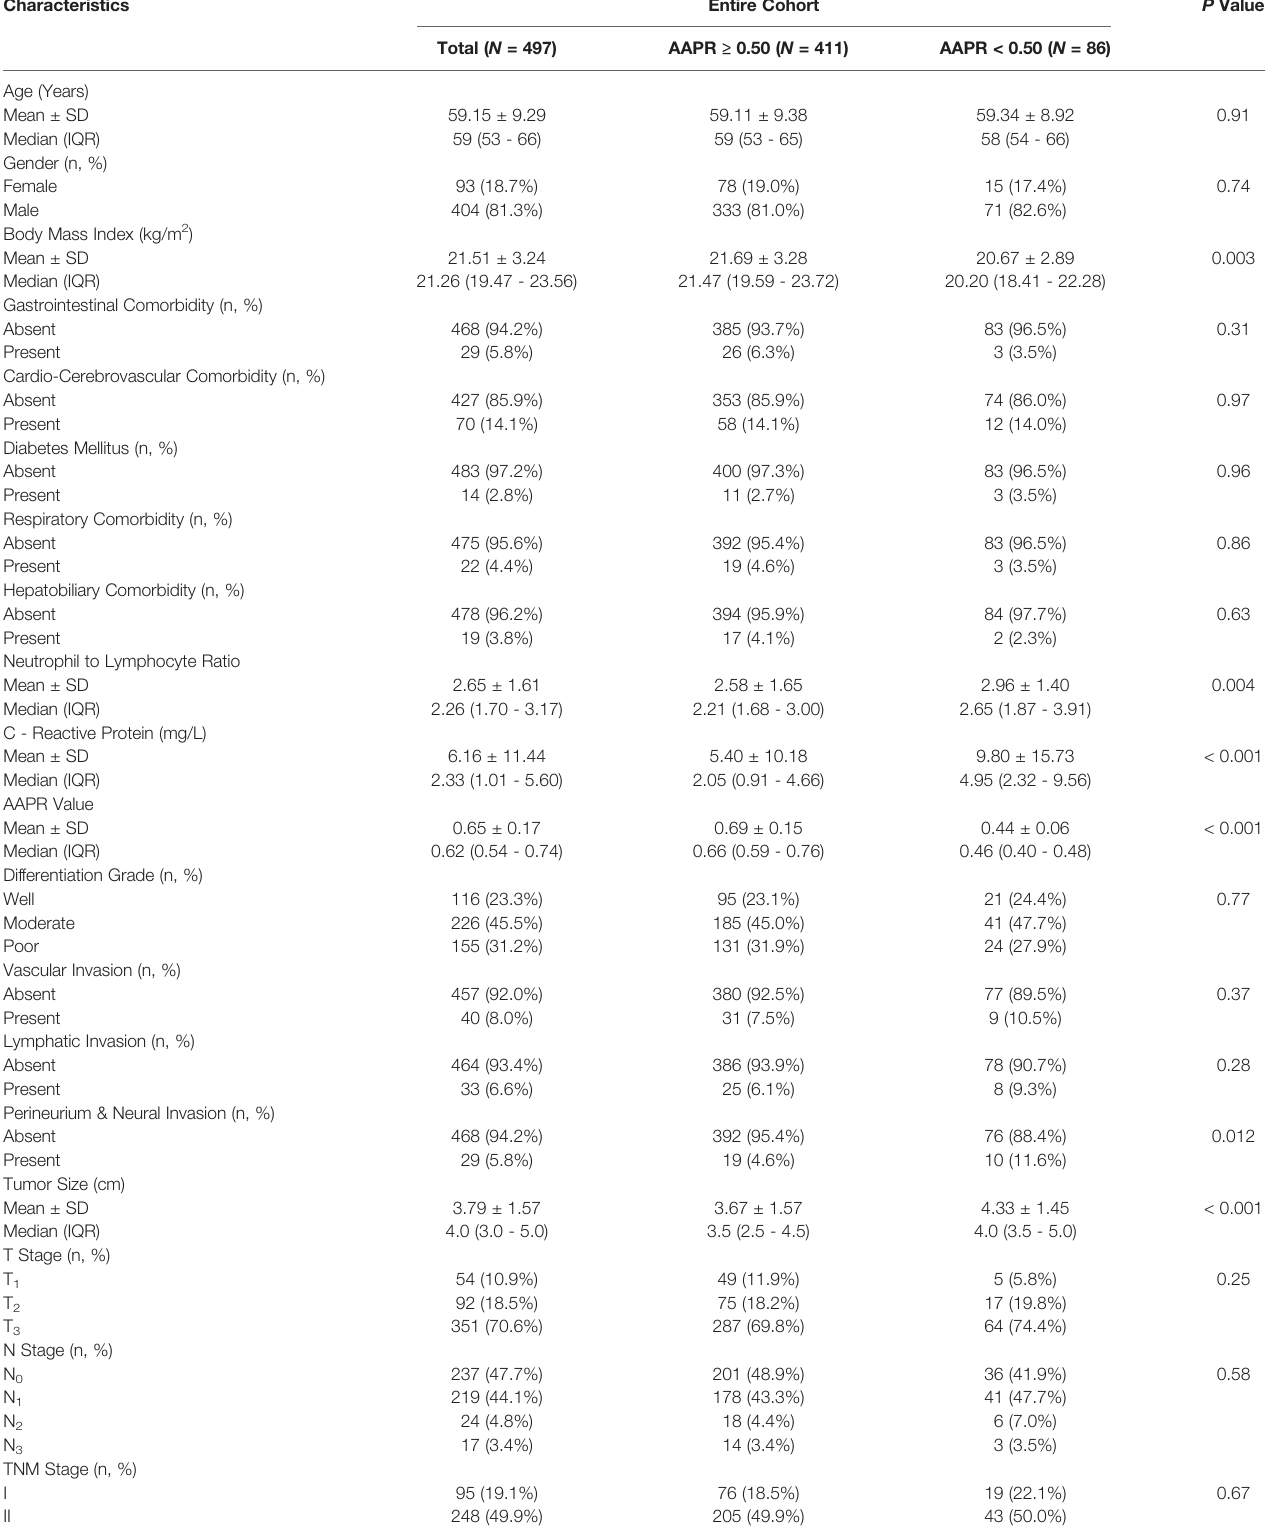
TABLE 1 | Patient characteristics and in-hospital outcomes of the entire cohort.